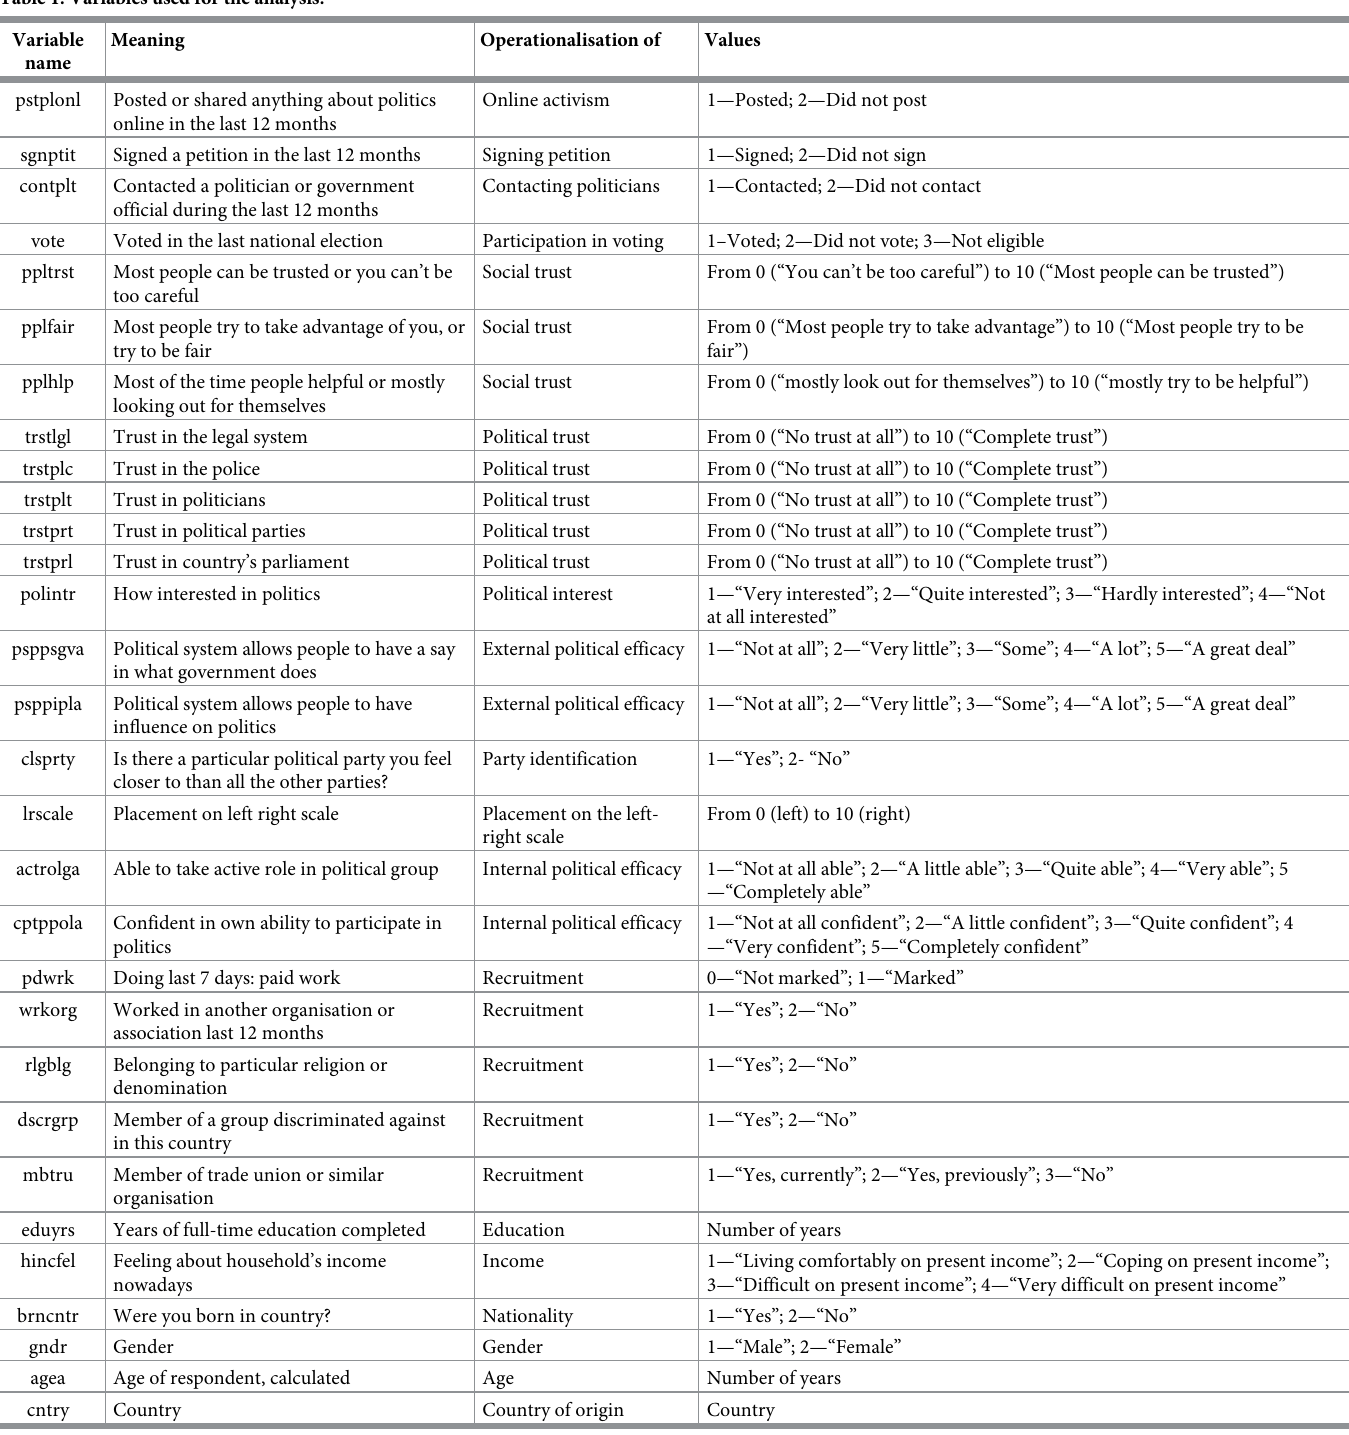
Table 1. Variables used for the